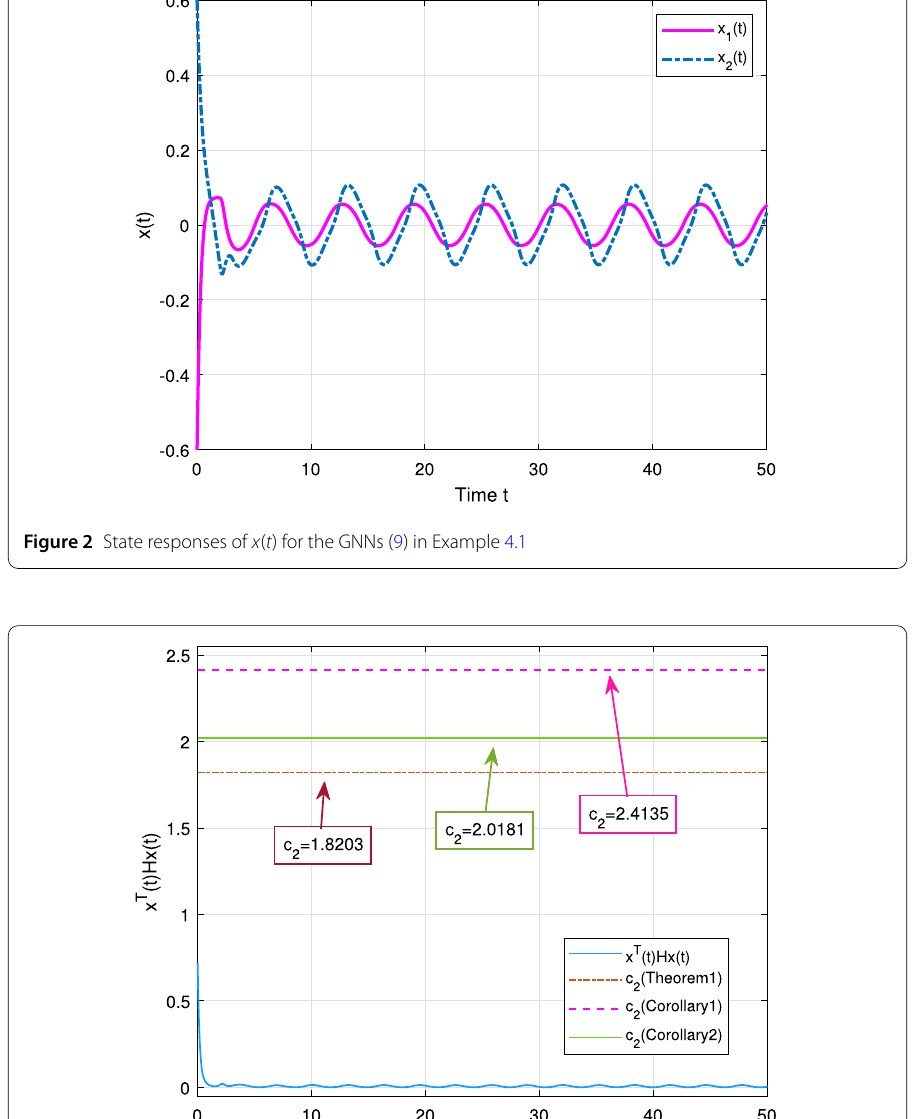
(cid:14) –0.6 cos ( t ) 0.6 cos ( t )